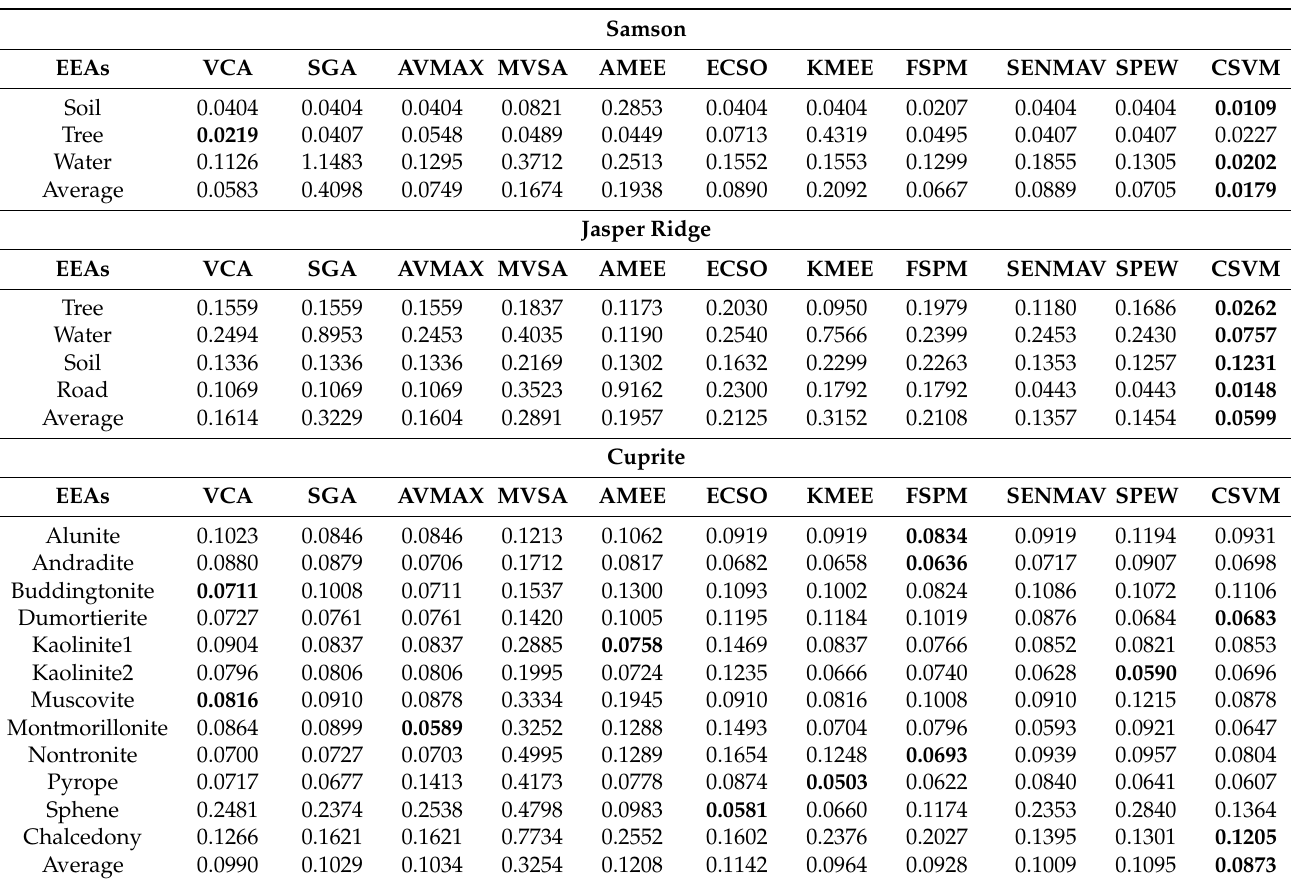
Table 1. SAD of all test algorithms on Samson, Jasper Ridge and Cuprite